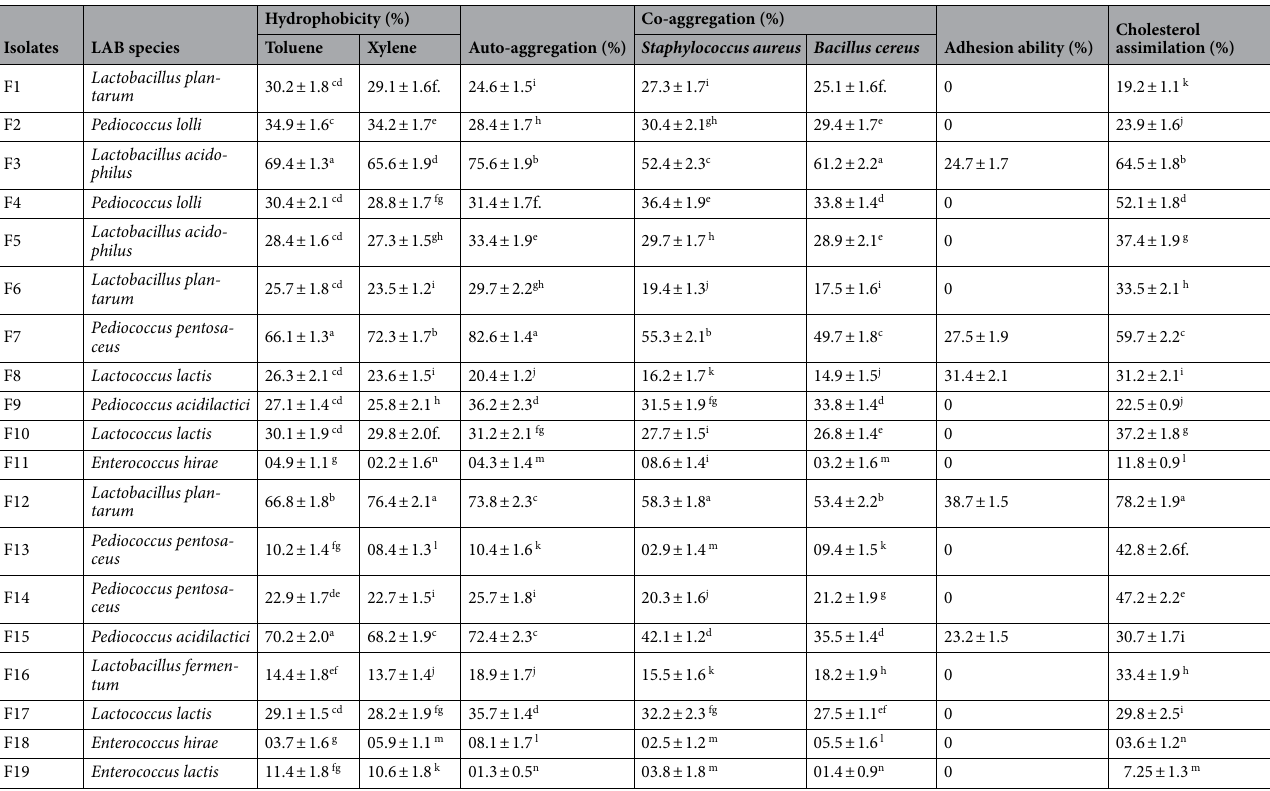
Table 3. Hydrophobicity, adhesion ability and cholesterol assimilation capacity of selected strains. Values are mean ± standard error. a–n Values followed by the same letters are not significantly different ( P > 0.05 ). Statistical analysis of each formulation was done